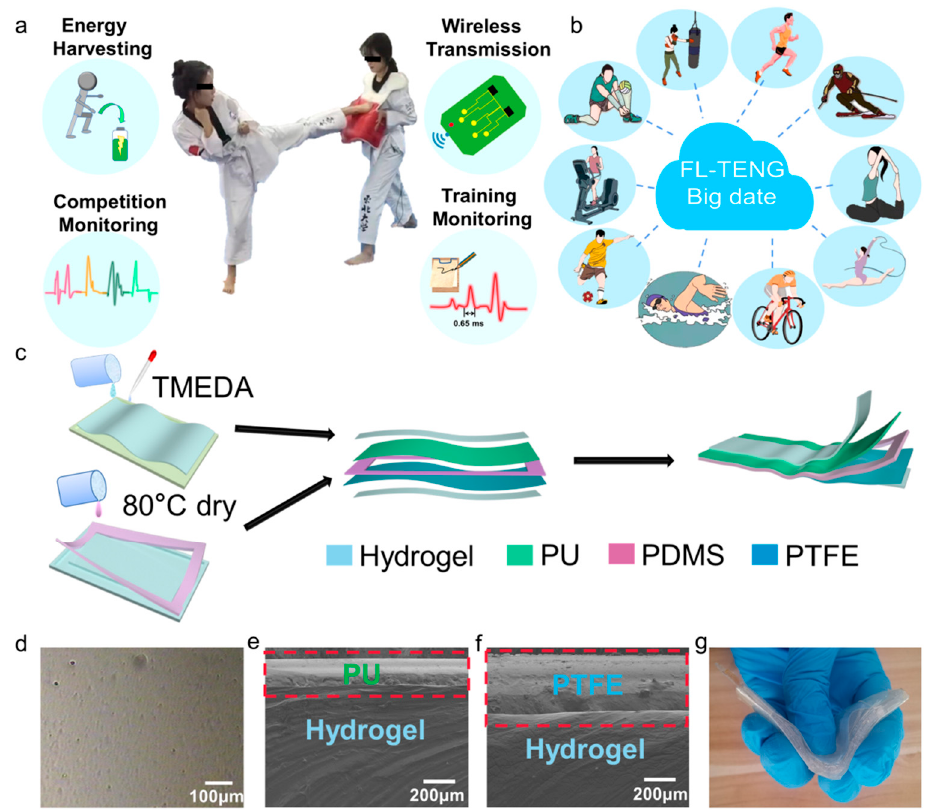
Figure 1. Application and production of FL ‐ TENG. ( a ) Application of FL ‐ TENG in taekwondo competition. ( b ) The sports application scenario of FL ‐ TENG. ( c ) The fabrication process of FL ‐ TENG. ( d ) The optical microscope image of polyurethane film. ( e ) The scanning electron microscope image of PU layer cross ‐ section. ( f ) The scanning electron microscope image of PTFE layer cross ‐ section. ( g ) The bending state of FL ‐ TENG.